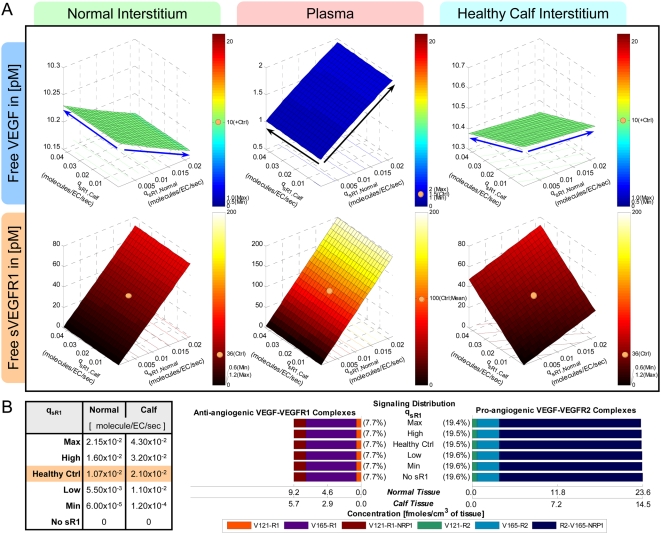
Targeting Control sVEGFR1-Secretion Rates (qsR1) for Basal Profile of Healthy Subject.A: Steady-state sensitivity of plasma and interstitial concentrations of free VEGF (top row) and free sVEGFR1 (bottom row) to qsR1 from normal tissue (y-axis) and calf (x-axis). Top row: Interstitial free VEGF decreased while plasma free VEGF increased with increasing qsR1. Blue/black arrows indicate inverse/direct relation between VEGF concentrations and sVEGFR1-secretion rates. Bottom Row: The targeted 100 pM of free sVEGFR1 was reached in plasma at the control secretion rates of qsR1,Ctrl = (qsR1,Normal, qsR1,Calf) = (0.0107,0.0210) molecule/EC/s. Beige spheres mark the interstitial and plasma sVEGFR1 levels reached at qsR1,Ctrl. B: Density of VEGF-VEGFR complexes were insensitive to qsR1. Bracketed percentages are VEGF-bound fractional occupancies of total VEGFR, averaged (range<0.4%) between normal and calf compartments. In figure: ‘+’ = control; ‘max’, ‘min’ and ‘mean’ indicate targeted ranges; ‘EC’ = endothelial cell; ‘V121’ = VEGF121; ‘V165’ = VEGF165; ‘R1’ = VEGFR1; ‘sR1’ = sVEGFR1; ‘R2’ = VEGFR2.